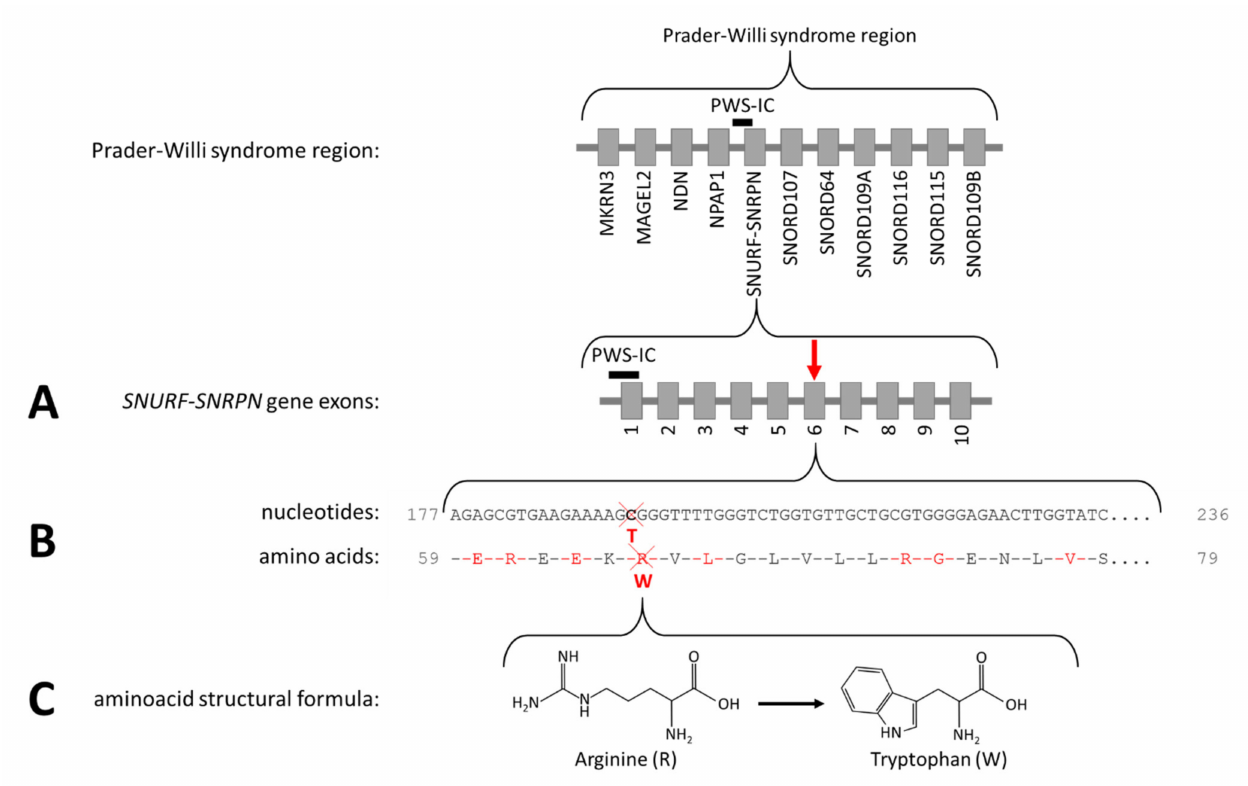
Figure 2. The Prader–Willi syndrome region and NM_003097.3( SNRPN ):c.193C>T, p.(Arg65Trp). ( A ) The arrow indicates the location of the variant in the SNURF-SNRPN gene. ( B ) The cross indicates the location of the affected nucleotide and the amino acid. ( C ) The structural formula of arginine and